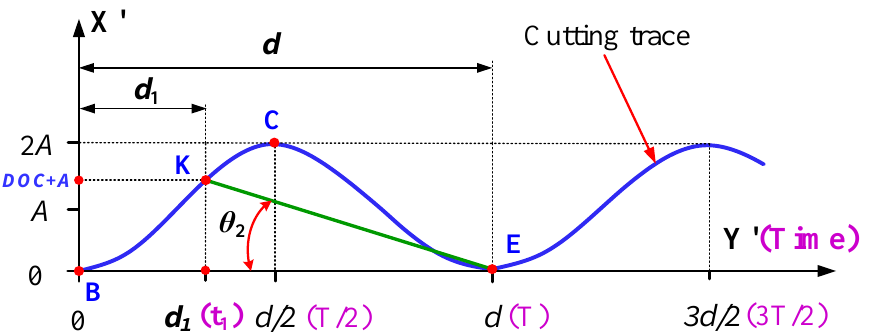
Figure 4. Sinusoidal cutting trace varying with time.